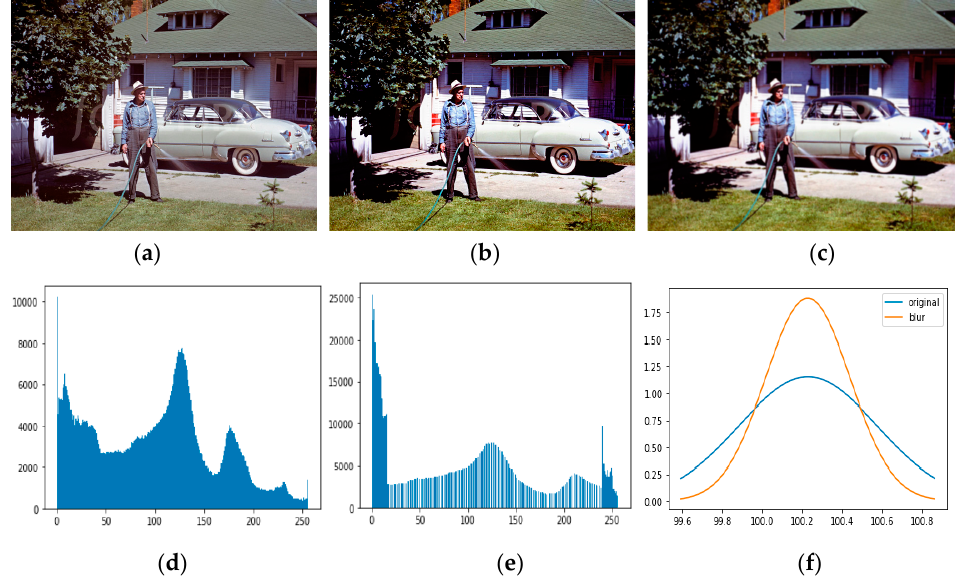
Figure 2. Results of image pre-processing ( a ) original image ( b ) sigmoid stretched image ( c ) filtered image ( d ) histogram of original image ( e ) histogram of sigmoid stretched image ( f ) mean and standard deviation plot of filtered image.